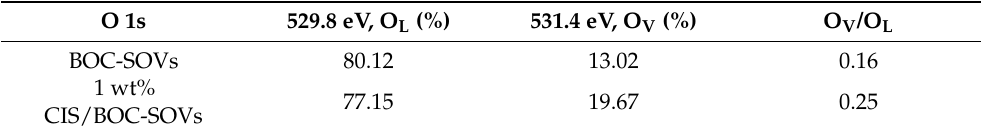
Table 1. Ratio of OV/OL of the BOC-SOVs sample compared with that of the 1% CIS/BOC-SOVs sample.